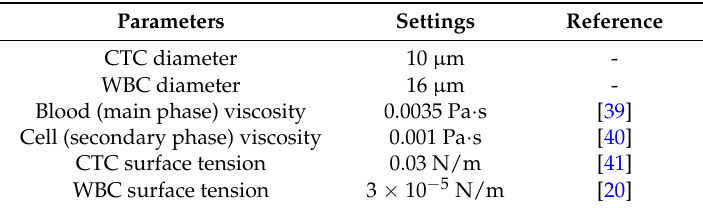
Table 1. The model settings in the volume of fluid (VOF)